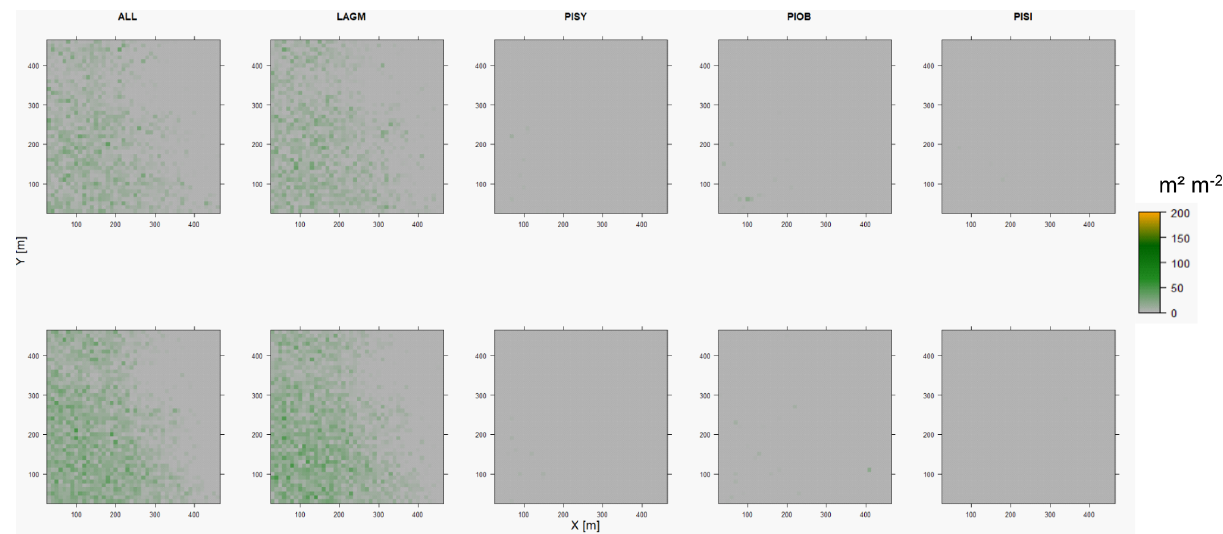
Figure D10. Leaf area index (LAI) values of the CryoGrid grid aggregated at year 2020 at Spasskaya Pad. Upper row shows LAVESI– CryoGrid coupled; lower row shows LAVESI simulations. LAGM: Larix gmelinii ; PIOB: Picea obovata ; PISI: Pinus sibirica ; PISY: Pinus sylvestris